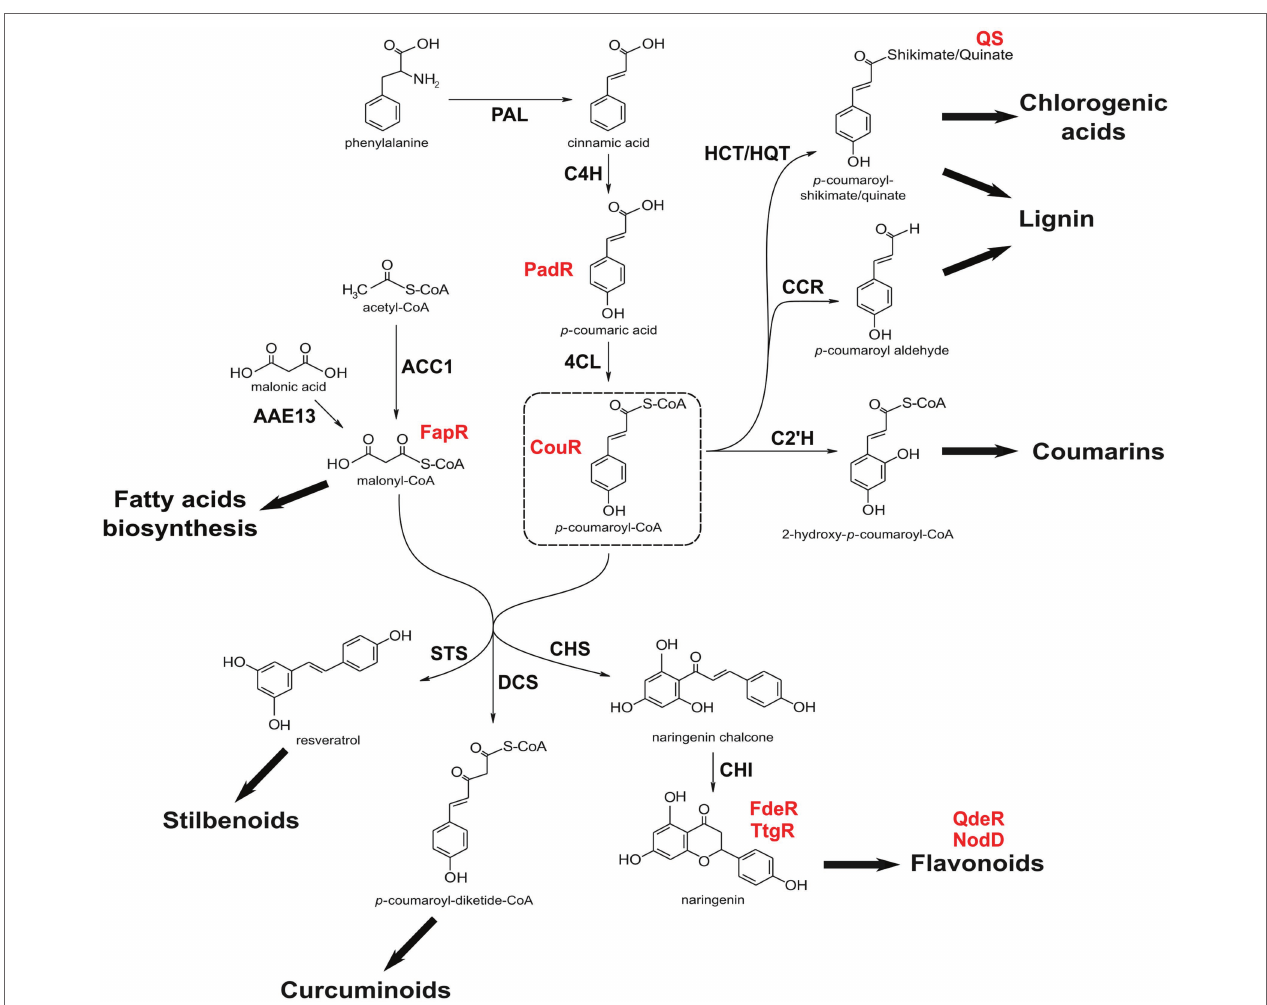
FIGURE 1 | Simplified phenylpropanoid pathway. Figure shows the conversion of phenylalanine into p -coumaroyl-CoA, from where most phenylpropanoid branches derive. Some reactions are not depicted for simplification and several phenylpropanoid derivates can have different branching points in addition to the ones shown here. Some of the sensor proteins discussed in the text are shown in red, right next to its respective ligand. Note that QS binds to quinic acid free form (quinate), not to p -coumaroyl-quinate. PAL, phenylalanine ammonia lyase; C4H, cinnamate 4-hydroxylase; 4CL, 4-coumarate-CoA ligase; HCT, p -hydroxycinnamoyl- CoA:shikimate p -hydroxycinnamoyl transferase; HQT, hydroxycinnamoyl-CoA:quinate hydroxycinnamoyl transferase; CCR, cinnamoyl-CoA reductase; C2’H, p - coumaroyl CoA 2 ' -hydroxylase; ACC1, acetyl-CoA carboxylase; AAE13, malonyl-CoA synthetase; STS, stilbene synthase; DCS, diketide-CoA synthase; CHS, chalcone synthase; and CHI, chalcone